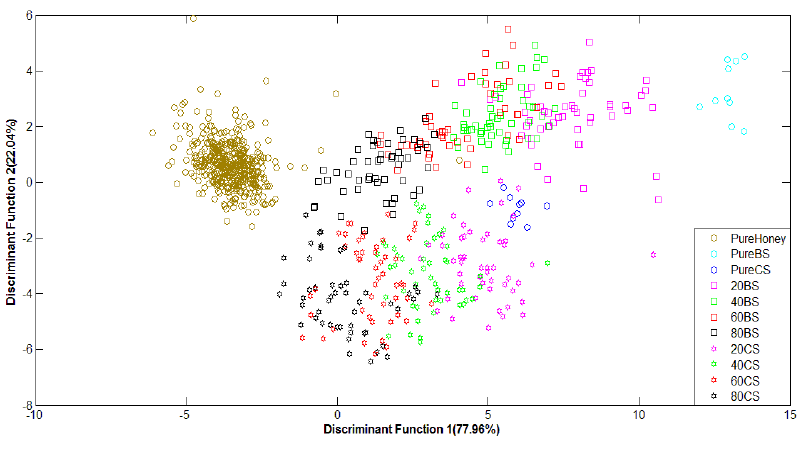
Figure 10. LDA plot of LLF normalized data (e-nose and